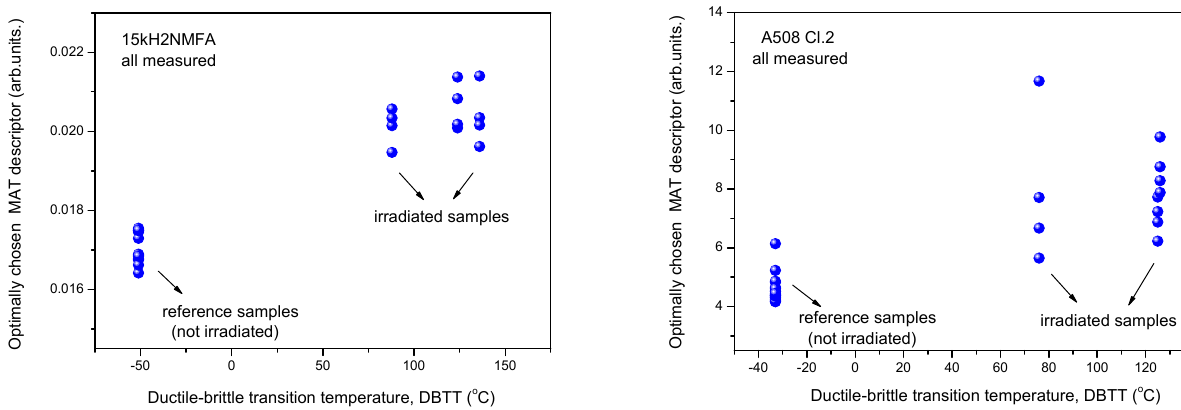
Figure 3. Optimally chosen MAT descriptor vs. transition temperature for all measured 15kH2NMFA and A508 Cl.2 samples.